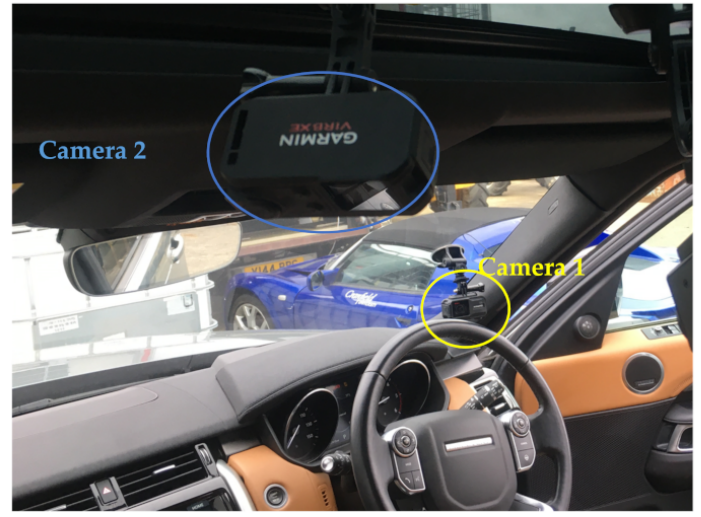
Figure 5. A illustration of the two cameras inside the vehicle.